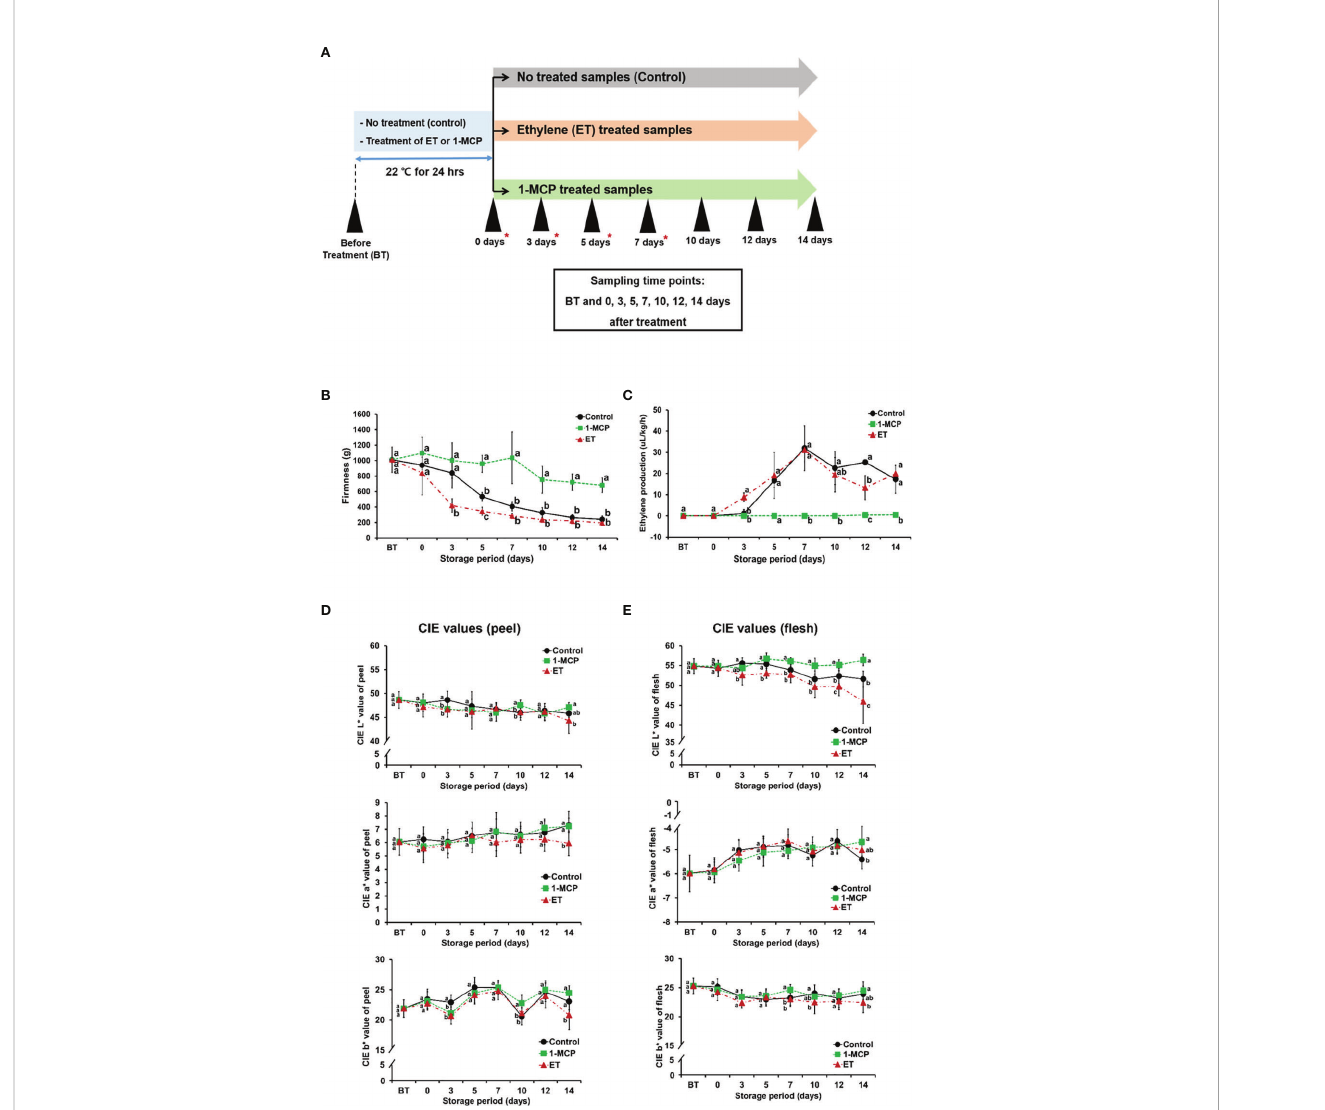
FIGURE 1 Characterization of fi rmness, ET amount, color (CIE L *, a *, and b * values) of control, ET-treated, and 1-MCP-treated kiwifruit throughout ripening. (A) Schematic diagram showing kiwifruit sampling along ripening time course. Kiwifruit harvested immediately before each treatment was named BT, before treatment. Kiwifruit exposed to ET or 1-MCP, or non-treated (named as control) for 24 h in a chamber, then analyzed without further storage, were named 0D samples. Kiwifruit samples further stored for certain durations (3, 5, 7, 10, 12, and 14 days) were named 3D, 5D, 7D, 10D, 12D, and 14D, respectively. Red asterisks indicate the samples used for RNA-seq analysis. (B) Firmness of kiwifruit treated with ET or 1-MCP and non-treated control samples along ripening time course. (C) ET production of kiwifruit treated with ET or 1-MCP and non- treated control samples along ripening time course. (D) Peel color ( L*a*b *) of kiwifruit treated with ET or 1-MCP and non-treated control samples along ripening time course. (E) Flesh color ( L*a*b *) of kiwifruit treated with ET or 1-MCP and non-treated control samples along ripening time course. (B – E) Data were expressed as mean ± standard deviation. One-way analysis of variance (ANOVA) with Tukey ’ s post hoc test was applied to calculate statistical differences. Different lowercase letters indicate signi fi cant differences (adjusted P < 0.05). ET, ethylene; 1- MCP,